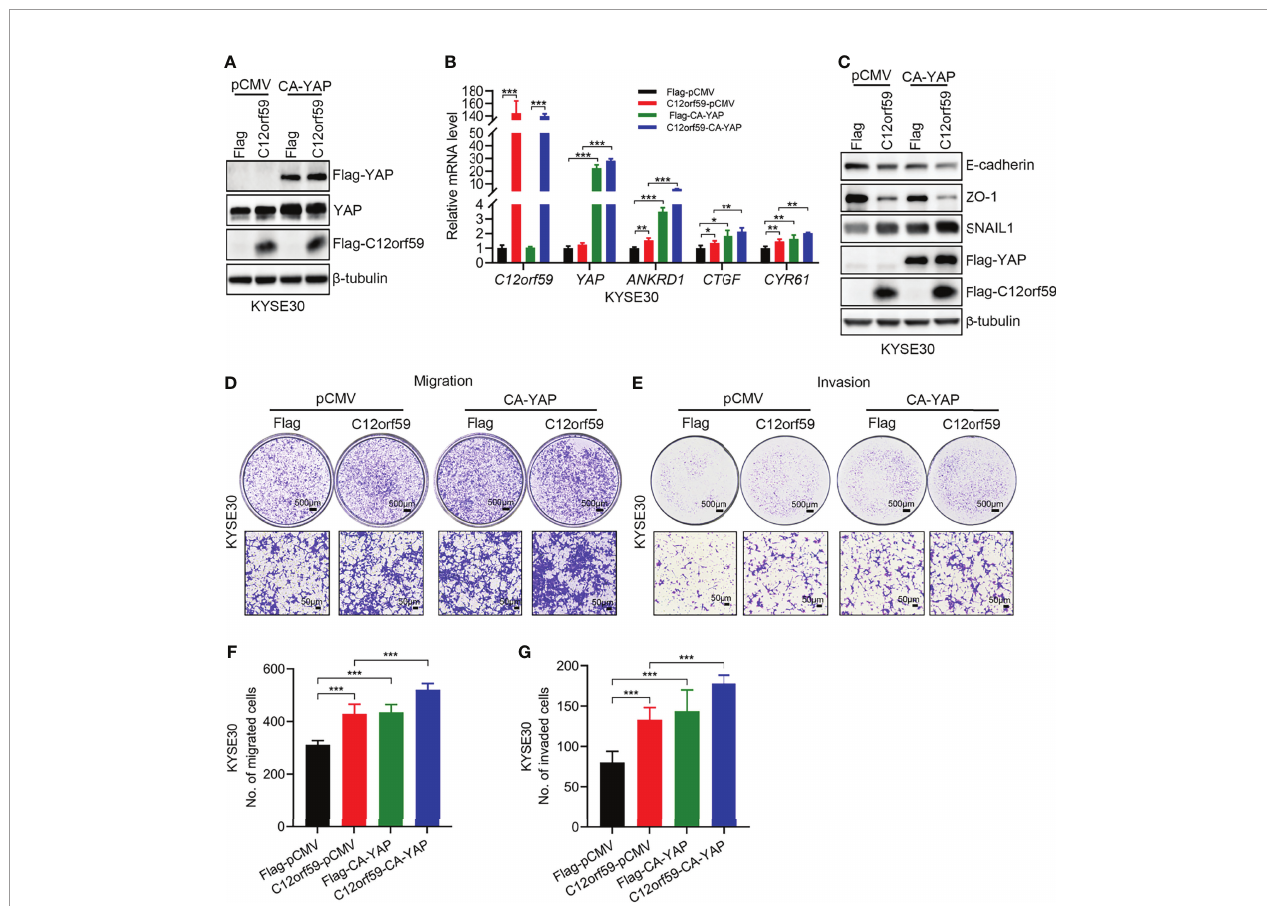
FIGURE 5 | YAP activation facilitates the EMT and cellular motility of ESCC cells. (A) KYSE30 cells with or without C12orf59 overexpression were transfected with control or constitutively active YAP (CA-YAP) plasmid. Cell lysates were subjected to western blotting for Flag and YAP to examine transfection ef fi ciency. (B) Real- time PCR was performed to examine the mRNA levels of C12orf59, YAP, and YAP target genes ( ANKRD1 , CTGF , and CYR61 ) in control and C12orf59- overexpressed KYSE30 cells introduced with or without CA-YAP-expressing plasmid. RPL19 was used as the internal control for real-time PCR. (C) Western blotting was performed to evaluate the protein levels of EMT markers (E-cadherin, ZO-1, and SNAIL1) in control or C12orf59-overexpressed KYSE30 cells transfected with or without CA-YAP. b -tubulin was used as the loading control for western blotting. (D, E) The effect of CA-YAP on cellular motility was investigated by transwell assays in control or C12orf59-overexpressed KYSE30 cells introduced with control or CA-YAP-expressing plasmid. Scale bar, 500 m m for low and 50 m m for high magni fi cation. (F, G) The number of migrated or invaded cells was counted and quanti fi ed. Data were presented as mean values with standard deviations, * p < 0.05; ** p < 0.01; *** p <